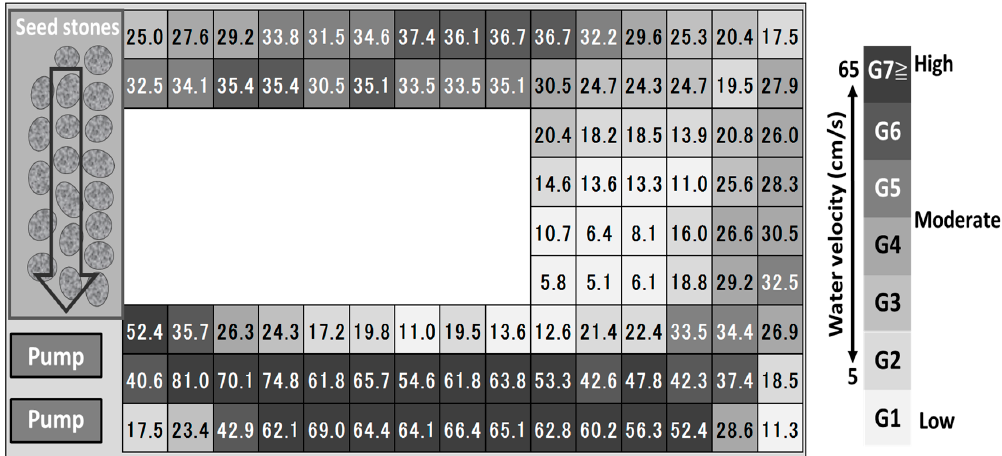
Figure 1. Distribution of near ‐ bed water velocity in the artificial streams, where G1–G7 are the velocity ranges in our study (indicated in grayscale) and the numbers in each square is the measured water velocity using a propeller meter (water in the aquarium flowed counter ‐ clockwise). Each aquarium contained about 40 L of water (outer dimensions 900 × 450 × 360 mm 3 , inner dimensions 400 × 180 × 280 mm 3 , W × D × H). Each tile was 45 × 45 × 9 mm 3 . Seed stones were natural cobbles collected from the Sagami River to inoculate the tiles with periphyton.